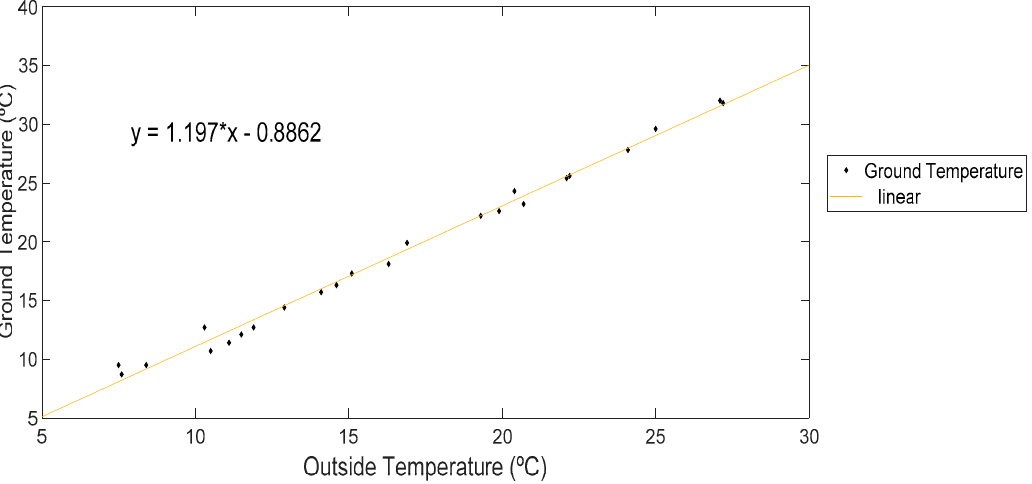
Figure 6. Relationship between ambient temperature and terrain temperature measured at 20 cm